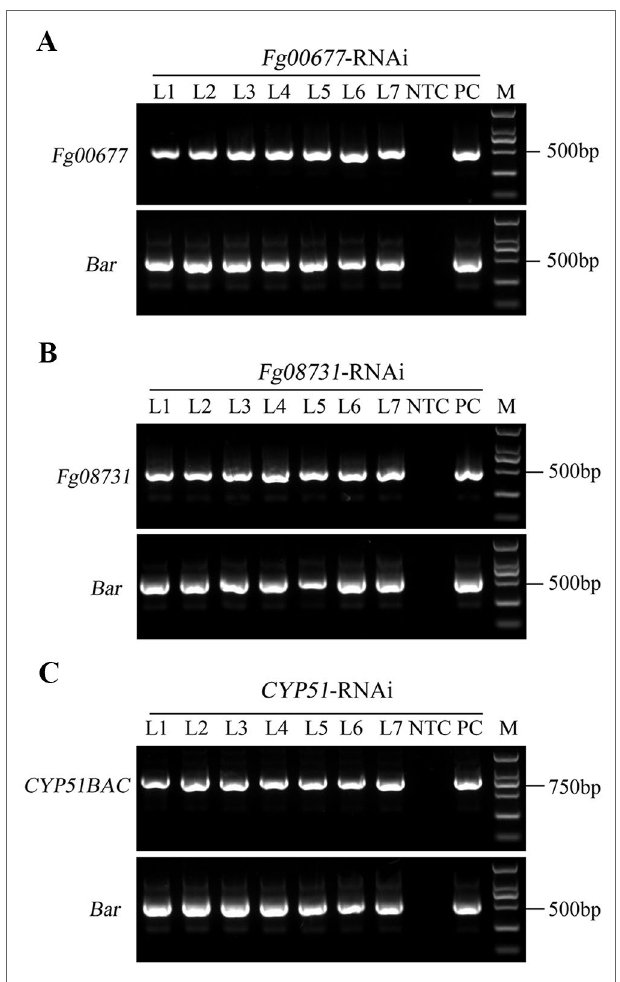
FIGURE 4 | Molecular analysis of transgenic B. distachyon . (a) Integration of Fg00677 -RNAi construct in transgenic plants analyzed by PCR amplification using Fg00677 and Bar gene-specific primers. (B) Integration of Fg08731 - RNAi construct in transgenic plants analyzed by PCR amplification using Fg08731 and Bar gene-specific primers. (C) Integration of CYP51 -RNAi construct in transgenic plants analyzed by PCR amplification using CYP51BAC and Bar gene-specific primers. The genomic DNA from non- transformed control (NTC) plants was used as negative control. The plasmid DNA, including FG00677-RNAi construct, FG08731-RNAi construct, or CYP51 -RNAi construct was used as positive control (PC); M indicates DL2000 DNA